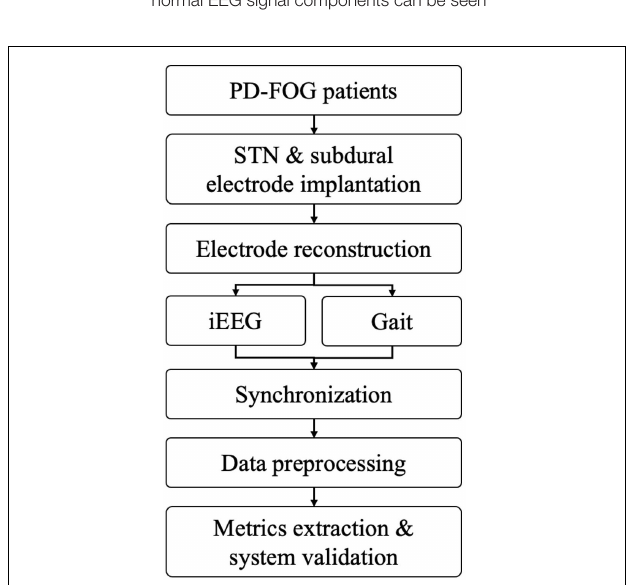
FIGURE 2 | The working flow of current methodology (PD-FOG, Parkinson’s disease with freezing of gait; STN, subthalamic nucleus; iEEG, intracranial